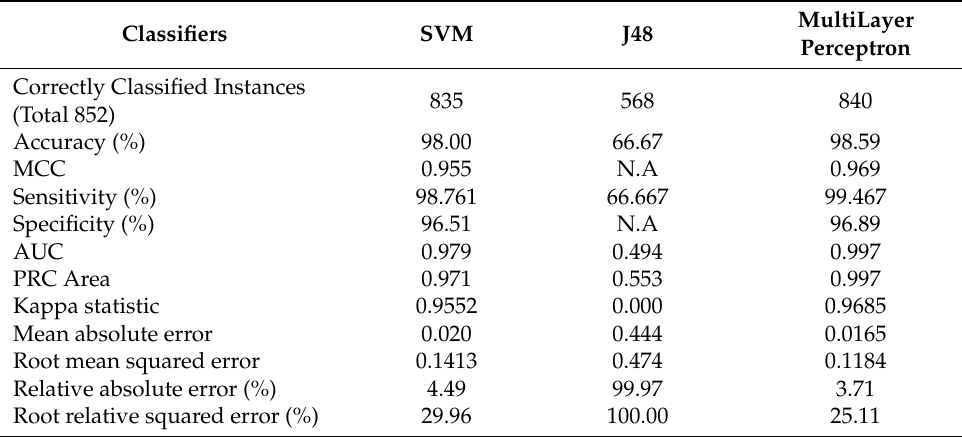
Table 2. Performance of ml classifiers on data after